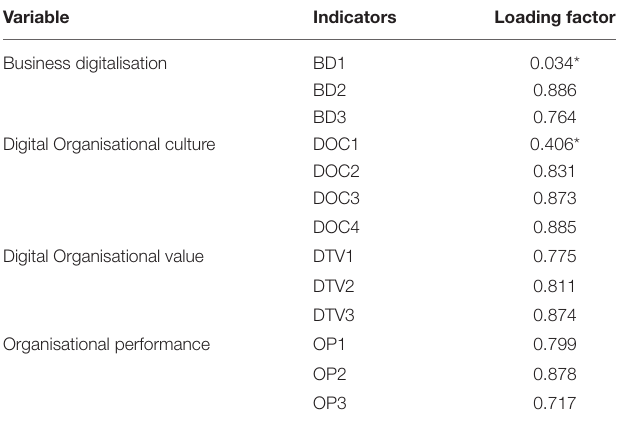
TABLE 3 | Fornell and Larcker test.